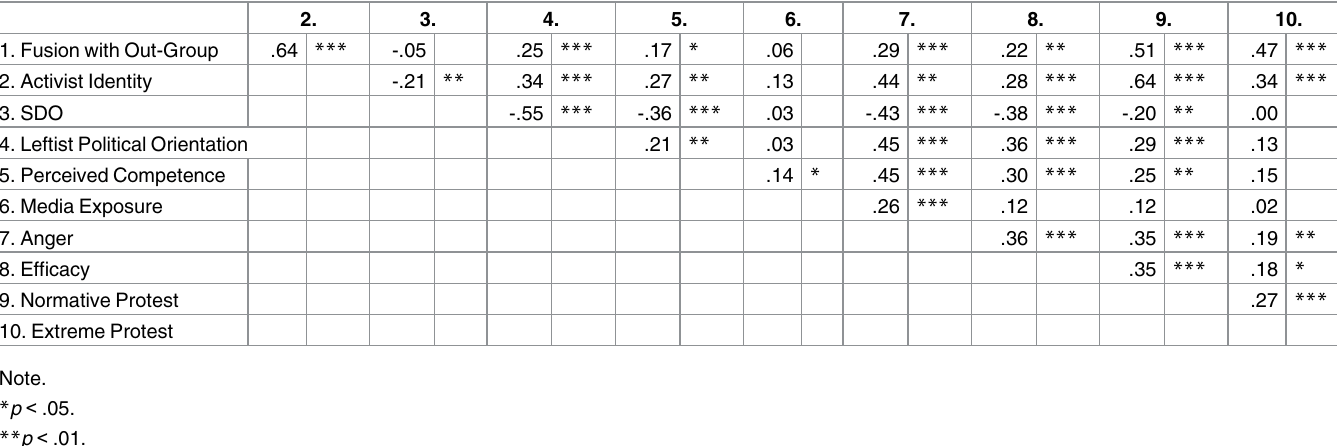
Table 3. Correlations between variables in Study 2 across conditions are